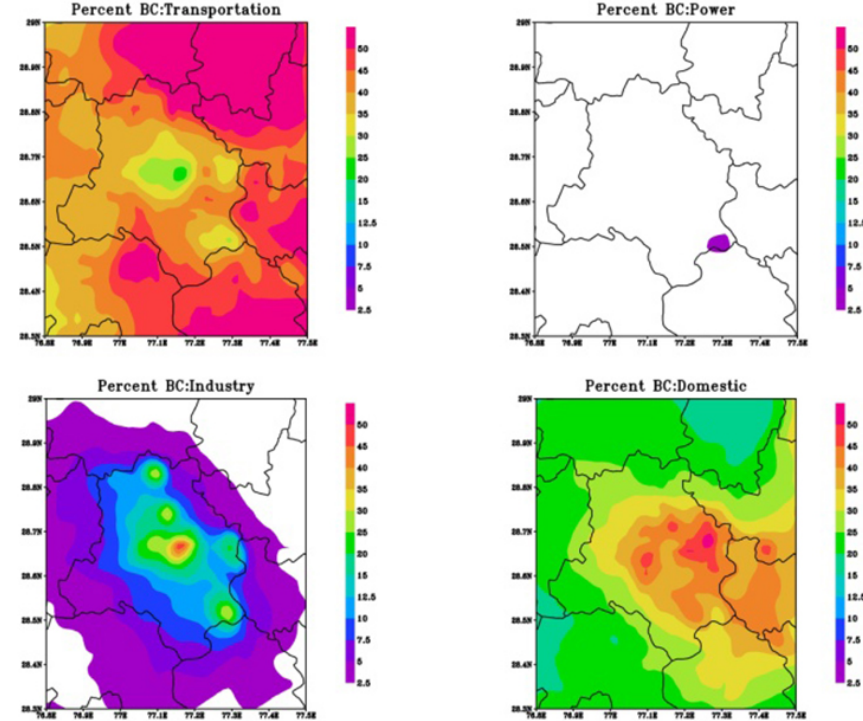
Figure 9. Spatial distributions of sector contributions to period mean surface BC concentrations.